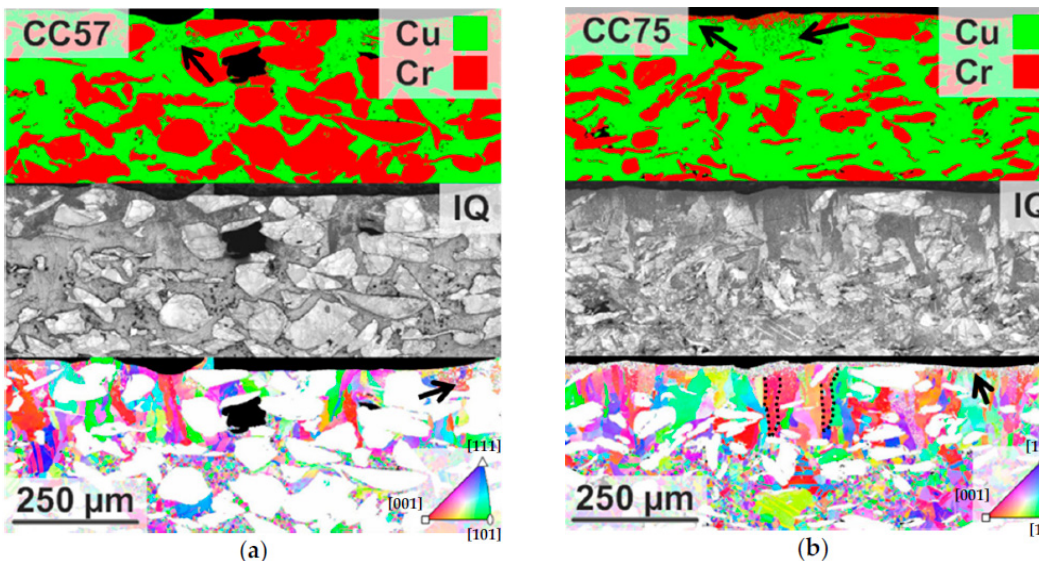
Figure 2. CC57 ( a ) and CC75 ( b ). From top to bottom: phase information (Cu and Cr are colour coded in green and red, respectively), image quality (IQ) and orientation of Cu (colour ‐ code corresponds to the inverse pole figure of the surface normal; inset). Arrows indicate small Cr ‐ particles solidifying from the liquid after switching. Dotted lines highlight elongated grains.